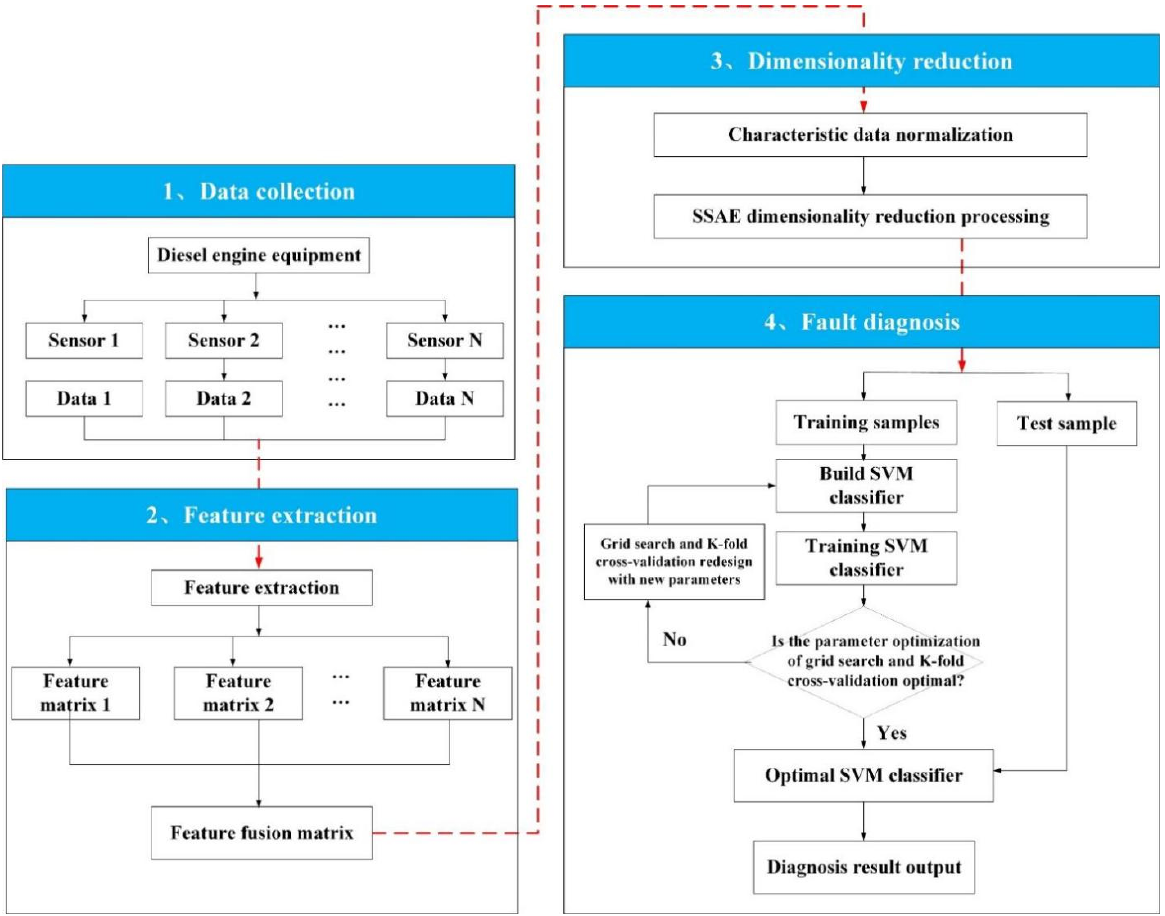
Figure 5. The process of the diesel engine fault diagnosis based on the SSAE-SVM method. Table 1. The parameters of the fault characteristics.